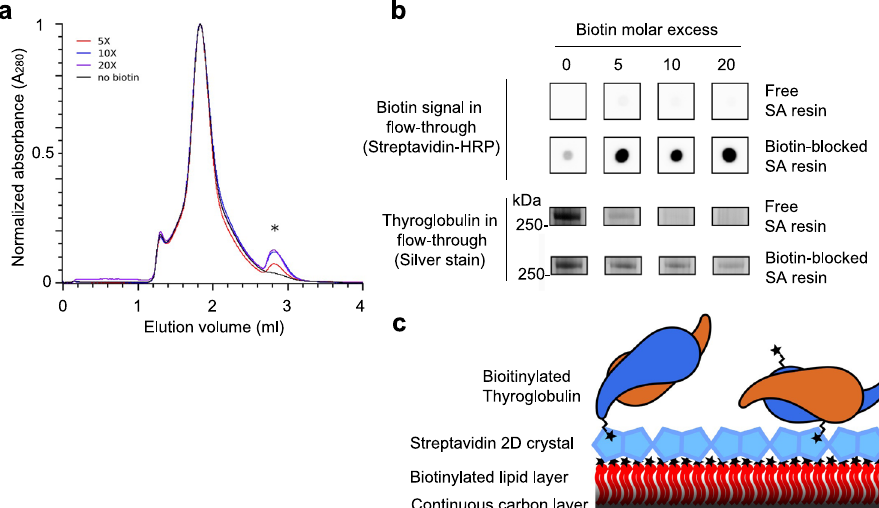
Fig. 1 Biotinylation, puri fi cation, and capture of native bovine Thyroglobulin (TG) on streptavidin af fi nity cryo-EM grids. a Elution pro fi le from preparative gel fi ltration chromatography (Superose 6 Increase GL resin) showing separation of biotinylated native TG from unreacted biotinylation reagents. Unbiotinylated control is plotted in black, and samples biotinylated with 5-, 10-, and 20-fold molar excess of biotin are plotted in the indicated colors. Asterisk, unreacted biotinylation reagents. b Analysis of TG biotinylation by adsorption to streptavidin (SA) resin. Top, streptavidin-HRP dot blots of SA resin fl ow-through fractions, as indicated. Bottom, silver-stained TG bands from SDS-polyacrylmide gel electrophoresis analysis of SA resin fl ow- through fractions, as indicated. Molecular weight marker running just below TG monomer is indicated at left. N = 3. Biotinylated TG from the 10-fold molar biotin reaction was selected for cryo-EM analysis on streptavidin af fi nity grids. Source data for TG SDS-PAGE analysis are provided as a Source Data fi le. c Schematic representation of randomly biotinylated homodimeric TG complexes (monomers are distinguished by blue and orange coloration) captured on a streptavidin af fi nity grid (streptavidin 2D crystal; pale blue; biotinylated lipids, red; continuous carbon, black). Stars represent biotins; tails protruding from the stars represent the fl exible 60-Å linker.